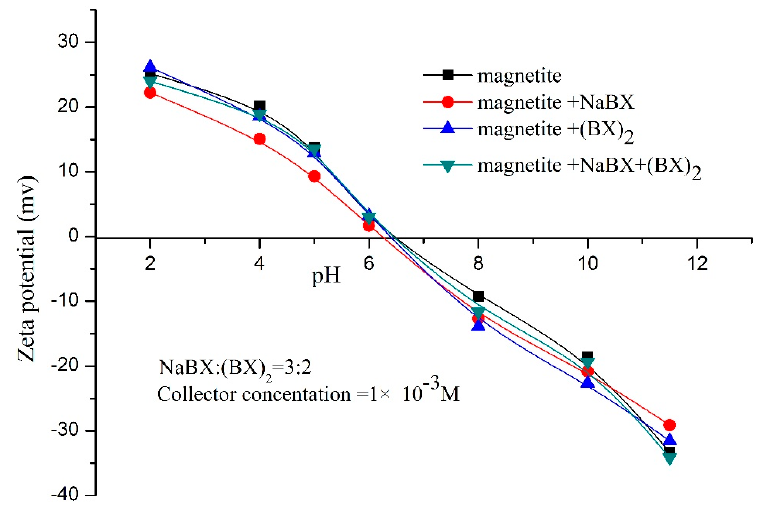
Figure 8. The zeta potential of magnetite in the absence and presence of NaBX, (BX) 2 , and their mixture as a function of pH value, respectively.